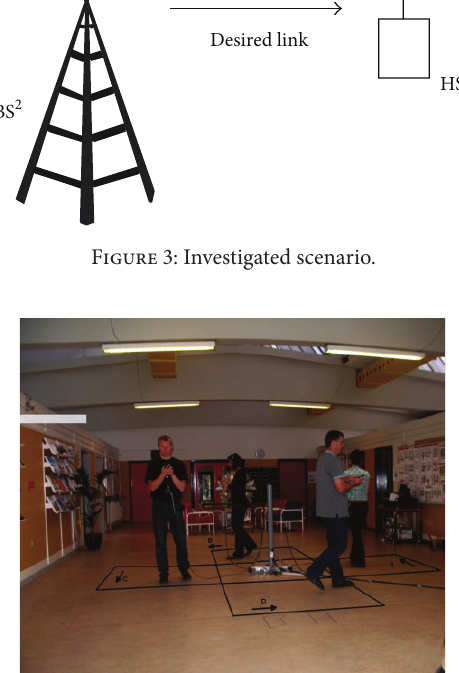
Figure 4: Measurement room.